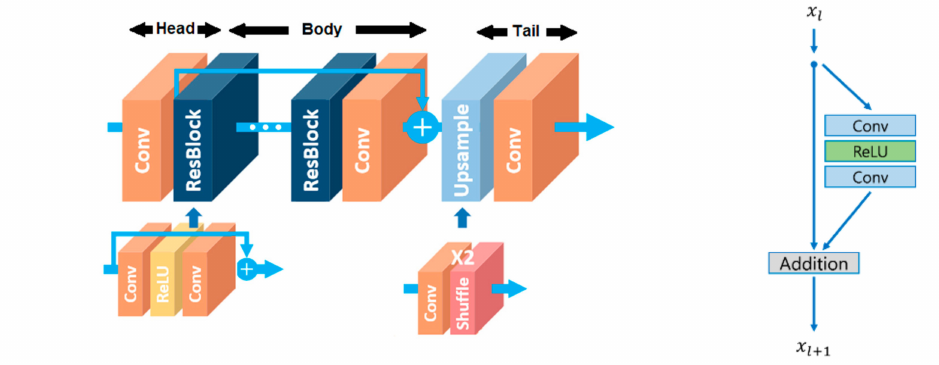
Figure 4. Single scale EDSR architecture and a residual block in EDSR